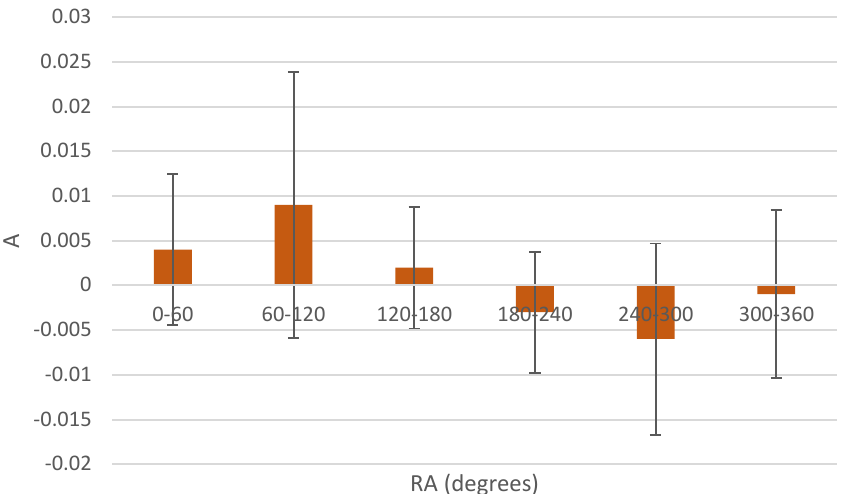
Figure 7. The asymmetry between the number of galaxies that spin clockwise and the number of galaxies that spin counterclockwise in different RA ranges when the galaxies are assigned with random spin directions.